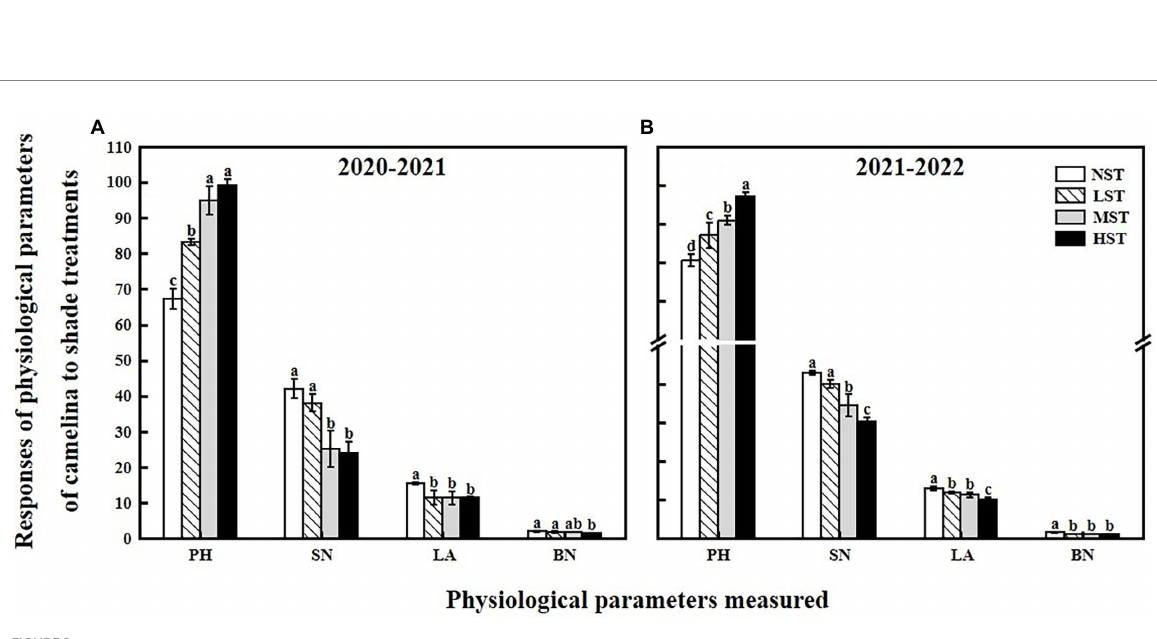
FIGURE 2 Responses of physiological parameters, including the plant height (PH, cm), the number of silicles plant − 1 (SN), leaf area (LA, cm 2 ), and the number of branches plant − 1 (BN) of camelina across the 16 genotypes to three different artificial shade levels (15%-LST, 25%-MST, and 50%-HST reduction in natural light intensity, respectively) in 2020–2021 (A) and 2021–2022 (B) . Individual values are means of each parameter measured across the 16 camelina genotypes ± stand errors. Different letters represent the significant different values by Tukey post-hoc test ( p ≤